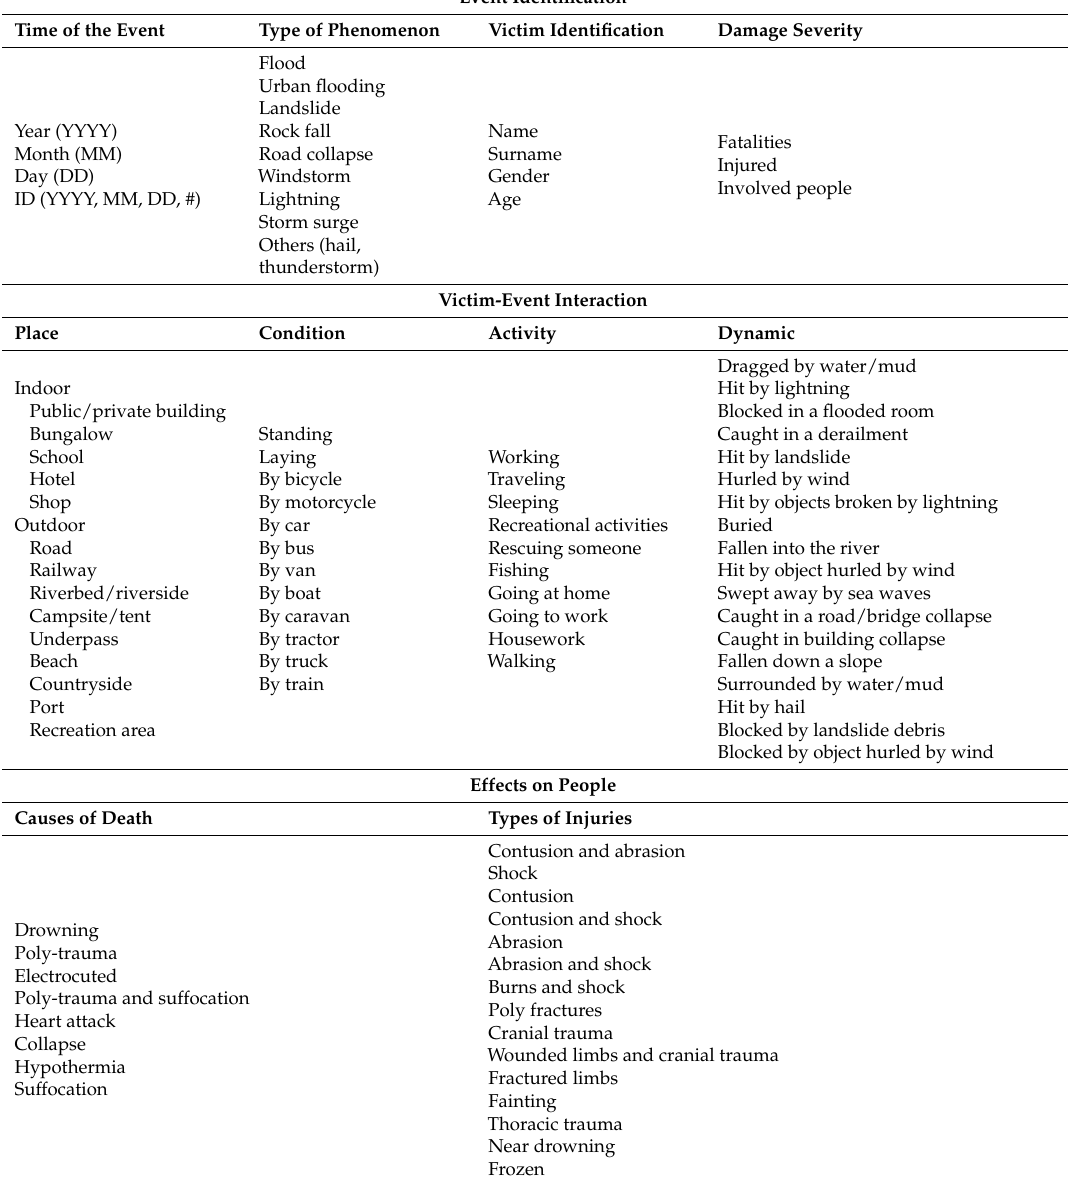
Table 3. Structure of PEOPLE